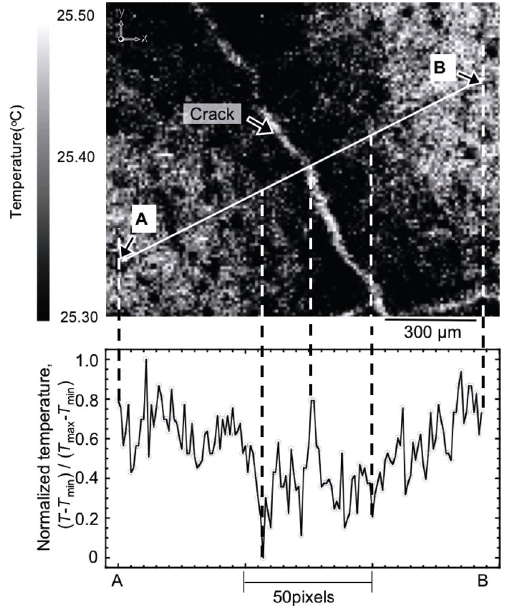
Fig. 6 Normalized temperature distribution around mud